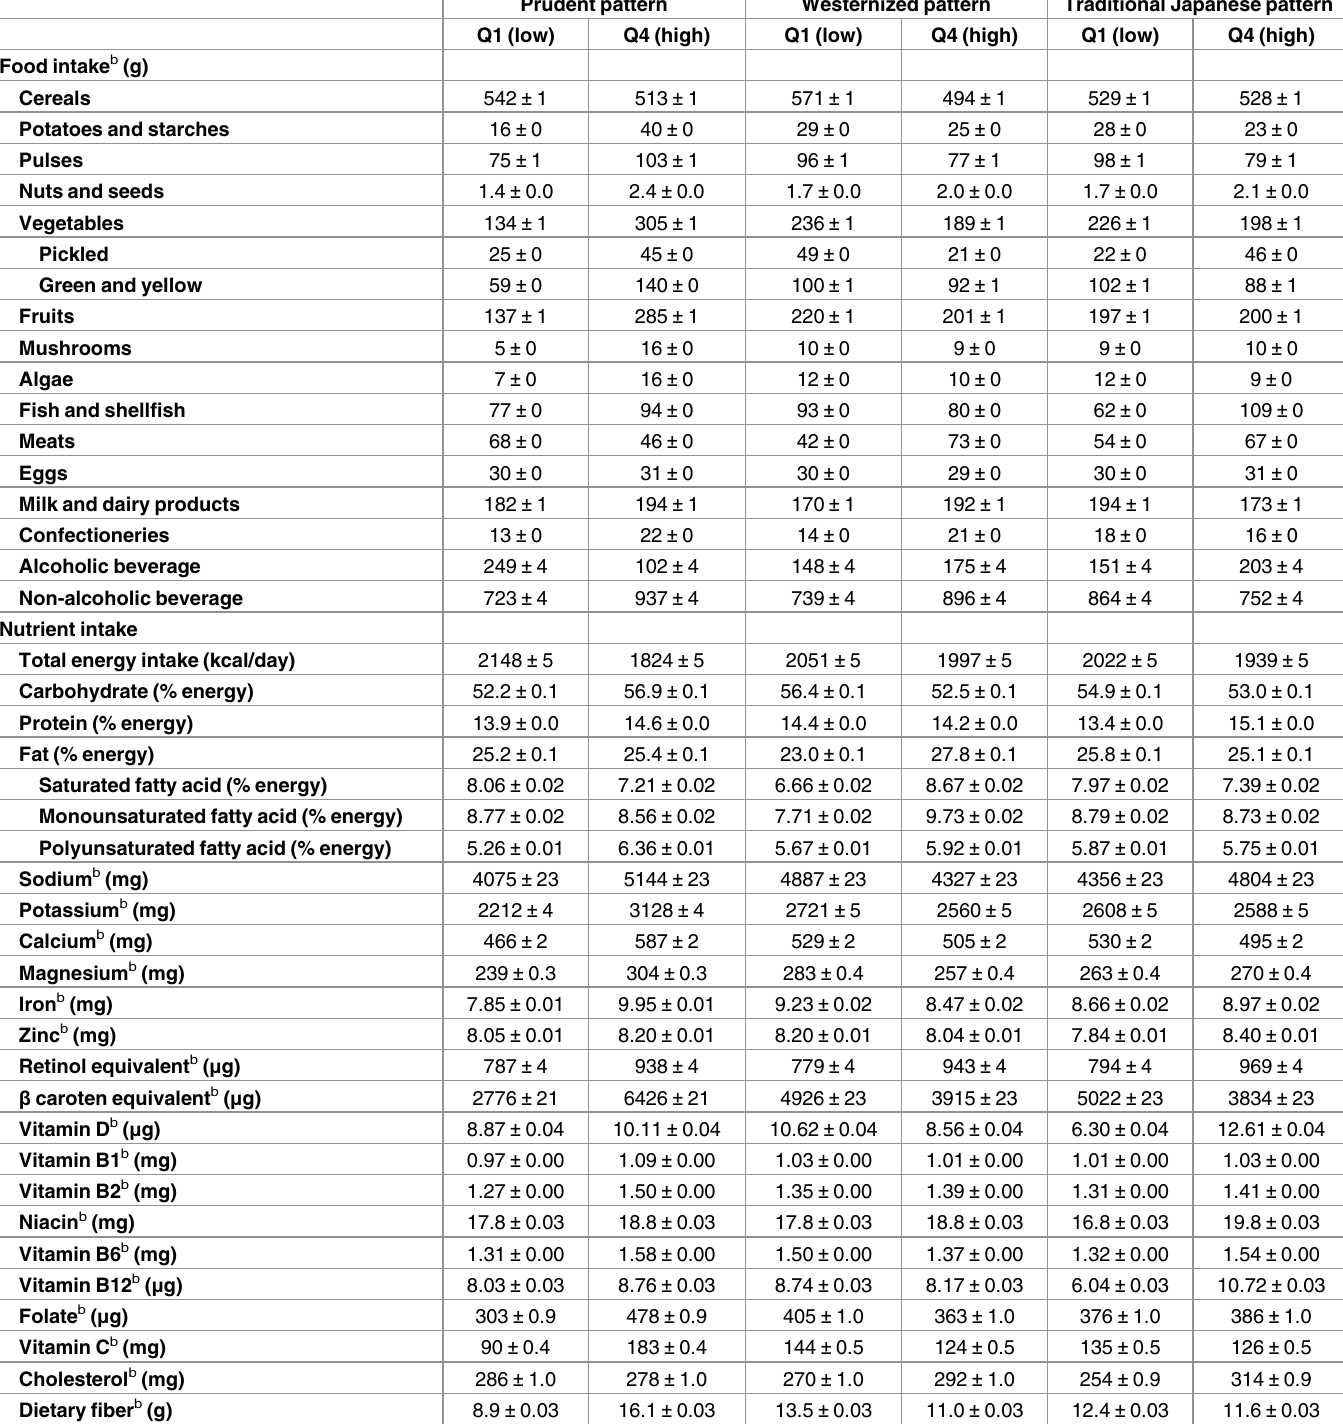
Table 2. Daily food and nutrient intake a according to quartile (Q) of dietary pattern